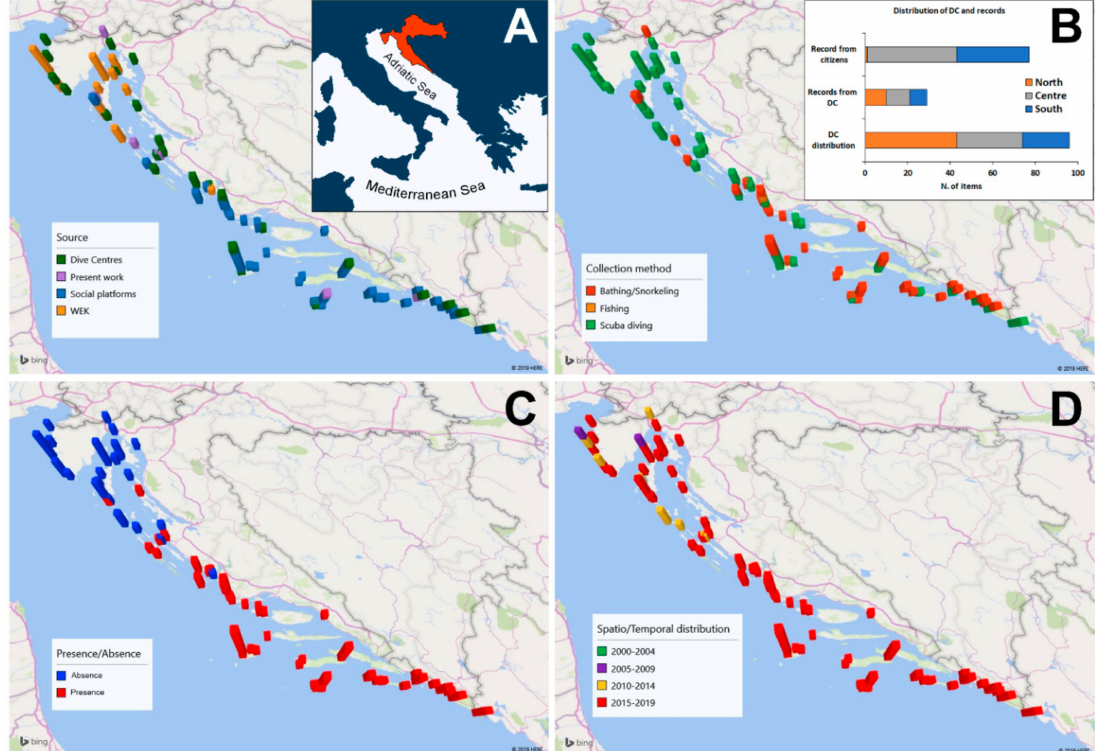
Figure 2. Record distribution and characterization. ( A ) Number and distribution of records discriminating between records from dive centers (DCs), social platforms, web ecological knowledge (WEK) and data obtained by scuba diving from the present work; ( B ) records distinguished by the method of collection; the bar histogram in the inset shows the proportion between records obtained from citizens and those gathered by DCs; moreover, the bars indicate that most dive centers are located in the north, while people participating in this work mainly come from the central and the southern part of Croatian coast; ( C ) number and distribution of presence / absence records; ( D ) spatiotemporal distribution of